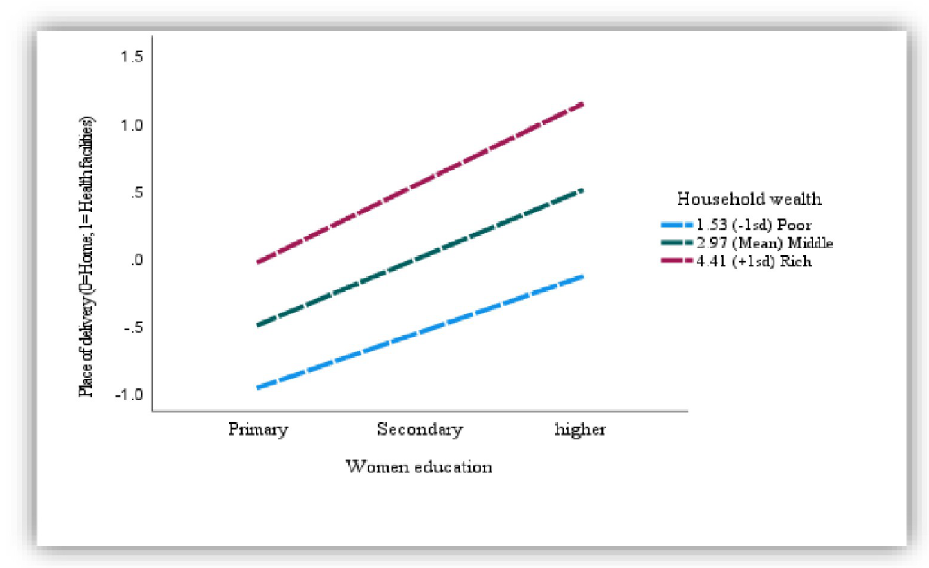
Fig 2. Plot of the relationship (moderated mediation) between delivery place and women education at -1sd, mean, and +1sd household wealth (Conditional effect of the focal predictor).